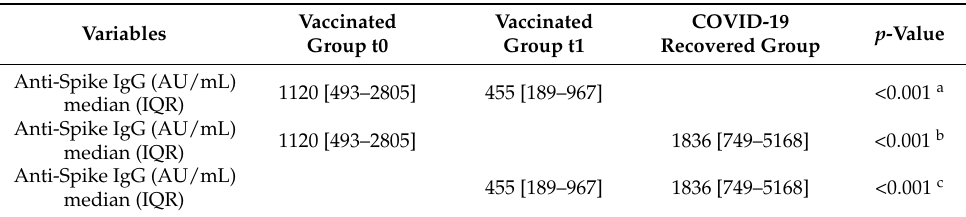
Table 2. Comparison of humoral immunity status between the two groups: vaccinated at 3(t0) and 6 (t1) months and COVID-19 recovered (control group).